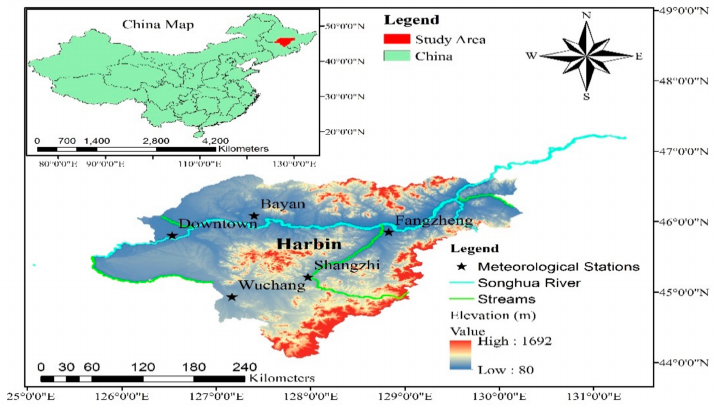
Figure 1. Location of the study